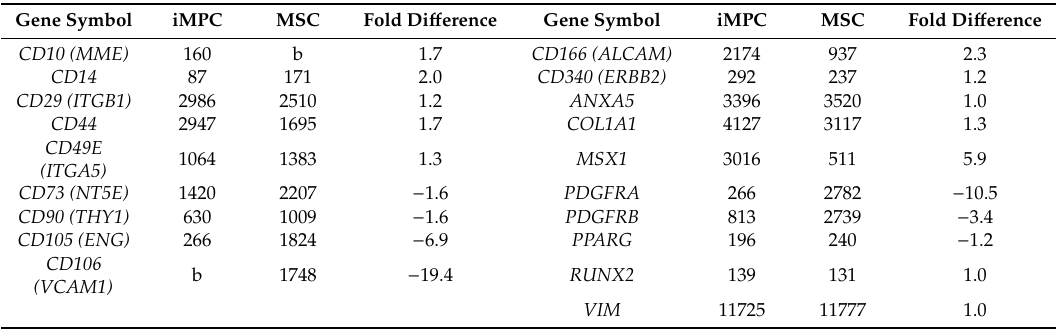
Table 1. Mean microarray expression levels of typical mesenchymal markers in expanded iMPCs and